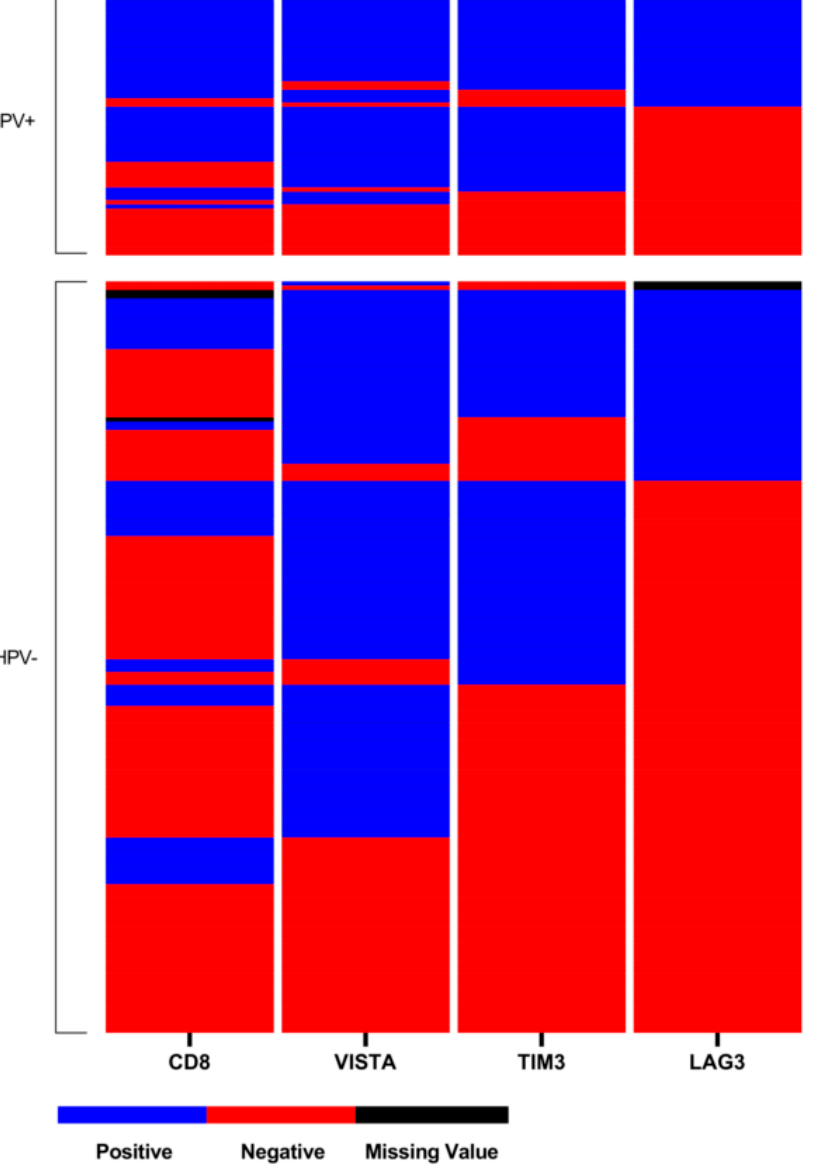
Figure 2. Heat-map of LAG-3, TIM-3, VISTA, and CD8 distribution within the tissue microarray (TMA). Each line presents one patient, whereas one column presents the expression of each immune-checkpoint marker on the TMA with blue indicating positive expression (>1%), red for negative expression ( ≤ 1%), and black for missing values.